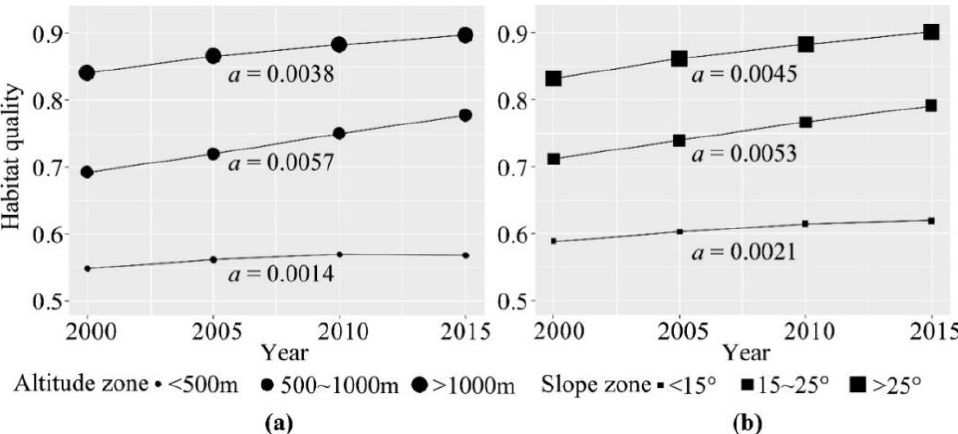
Figure 4. Temporal variations of the habitat quality in different altitude zones ( a ) and slope zones ( b ) in the TGR area. Note: We used a least-square linear regression model to fit the habitat quality score. The changing trend is described by the modelled slope which is a in the figure.